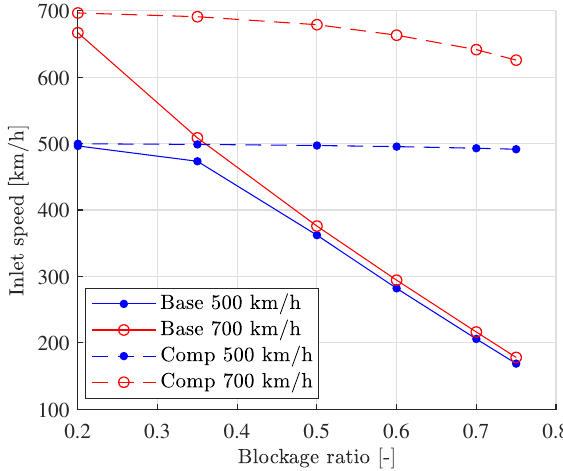
Figure 13. Inlet speed for the different blockage ratios and speeds.